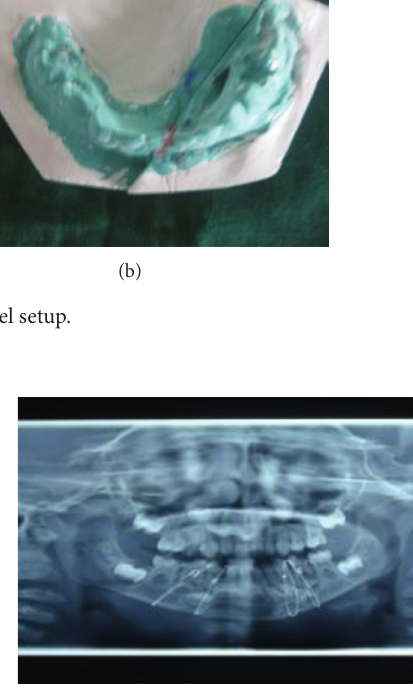
Figure 7: Intraoperative OPG with circummandibular wiring.